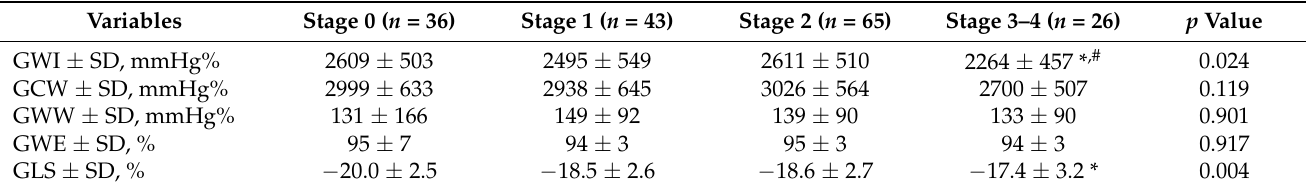
Table 2. MW parameters and GLS in AS patients according to stages of cardiac